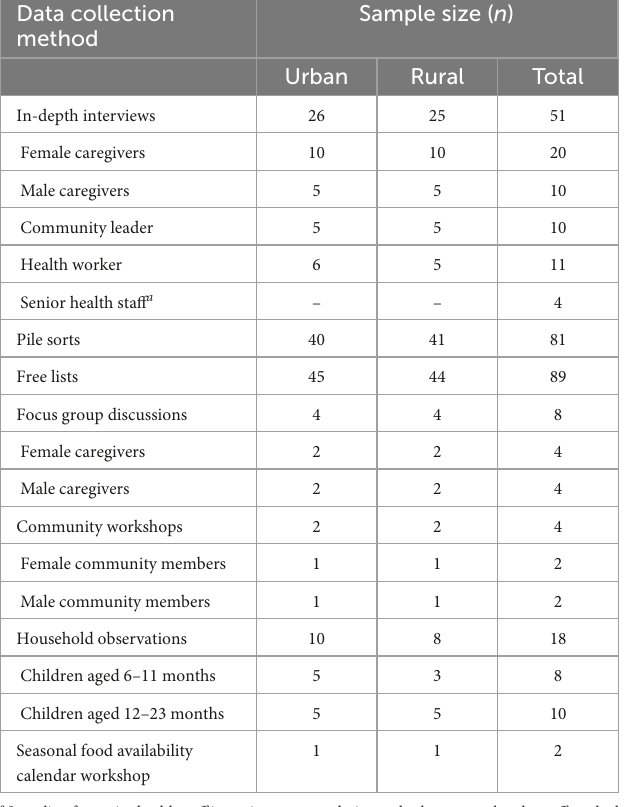
TABLE 3 Sample sizes by data collection method, participant type, and study site. Data collection